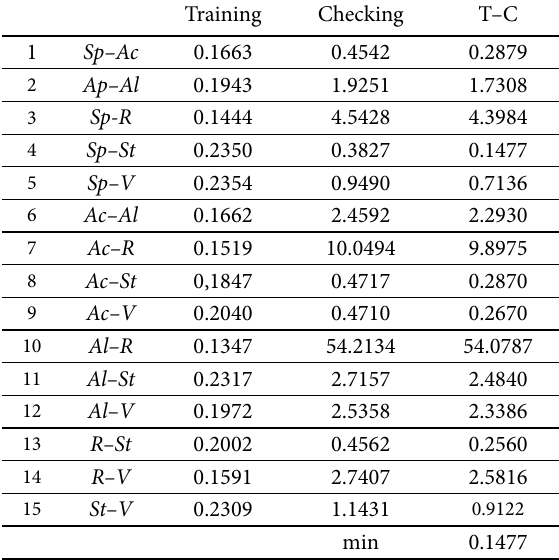
Table 2. Training and checking errors with two inputs at a time